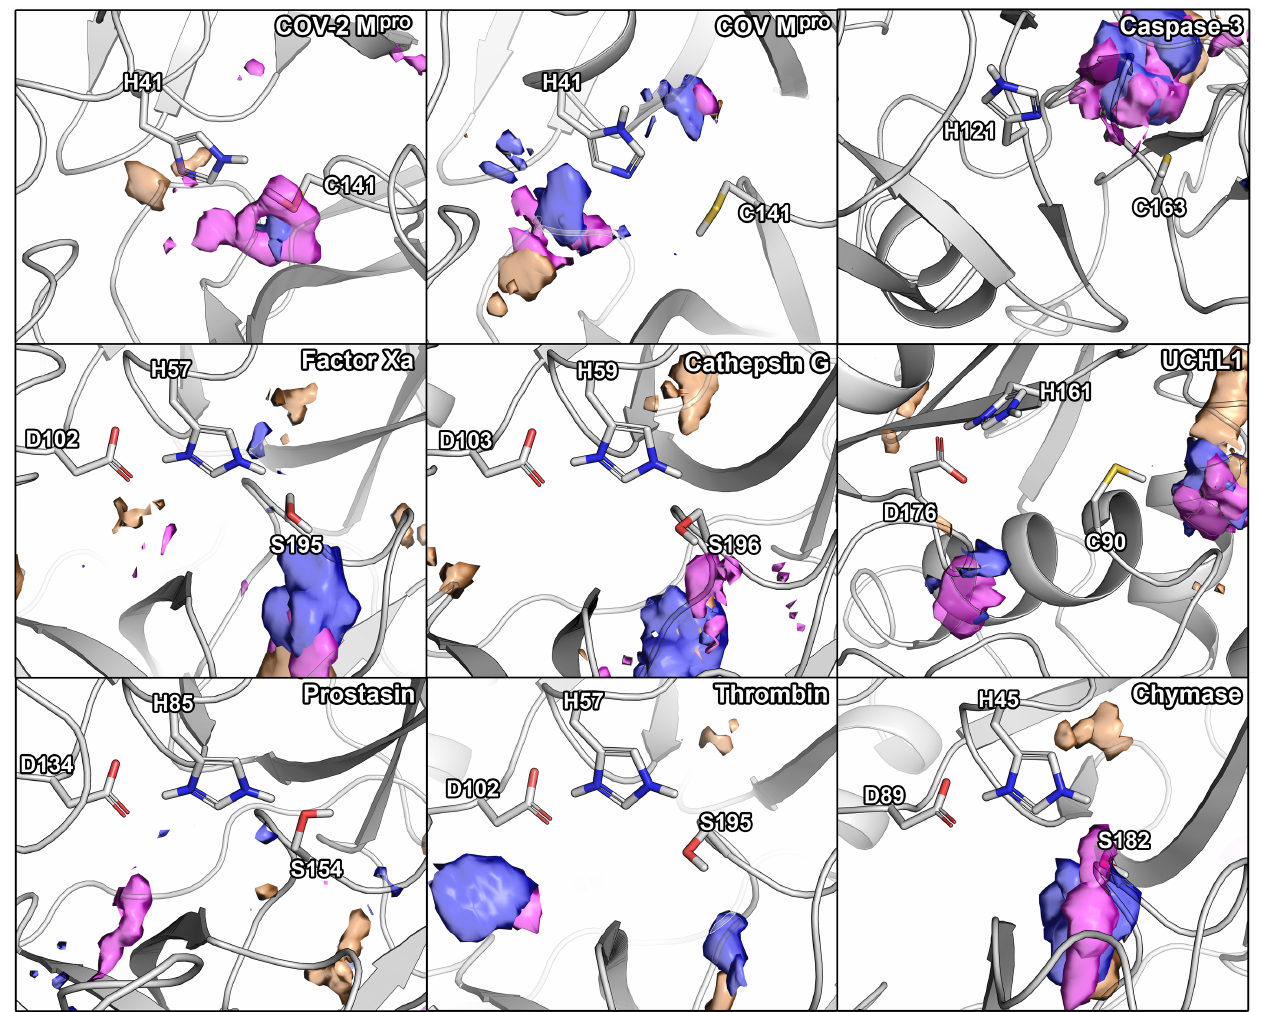
Figure 2. Small-molecule hot-spots of the selected panel of proteases in relation to their catalytic residues. Blue densities correspond to isopropanol, pink densities to pyridine, and orange densities to